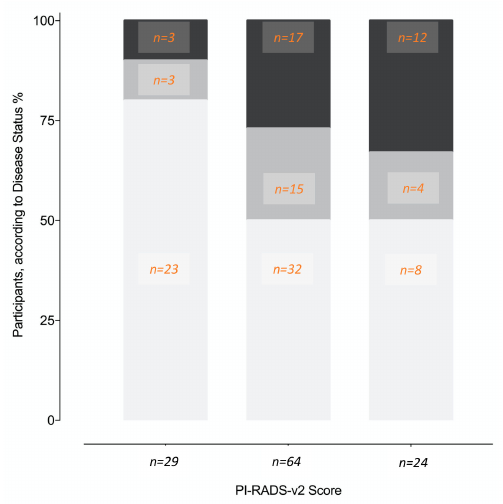
Figure 2. Proportions of di ff erent disease status (%, number of patients) on image-guided biopsy according to the PI-RADS-v2 score lesions. No cancer (white), non-high-grade cancer (light grey), high-grade cancer (dark grey).